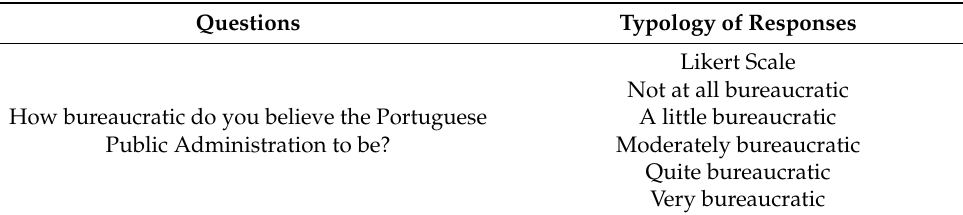
Table A1. Survey questions on the Portuguese